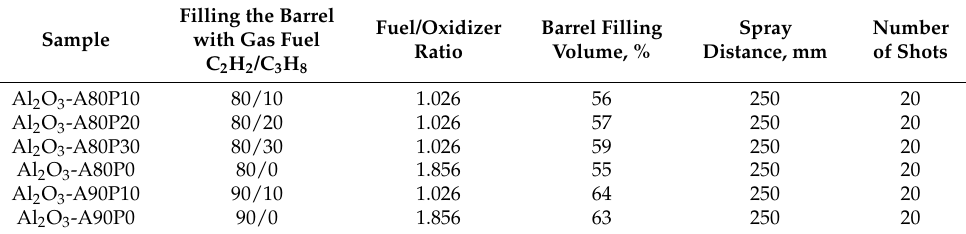
Table 1. Technological modes of spraying coatings from aluminum